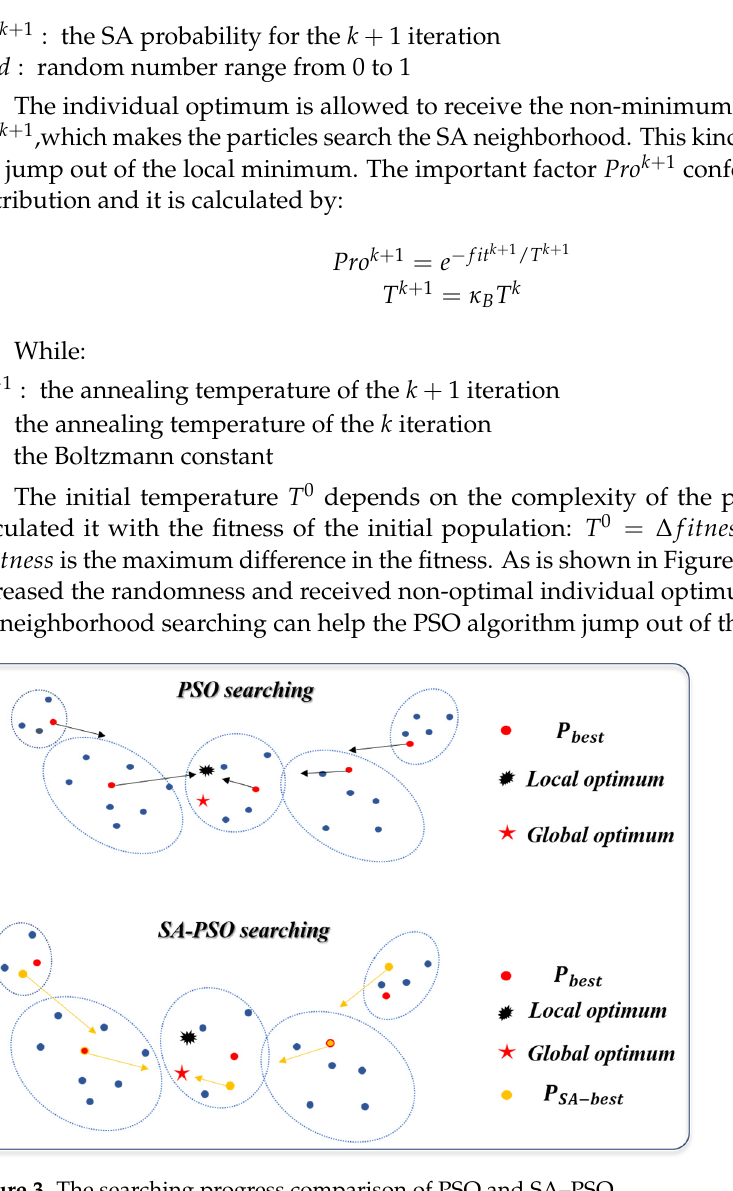
Figure 3. The searching progress comparison of PSO and SA–PSO.